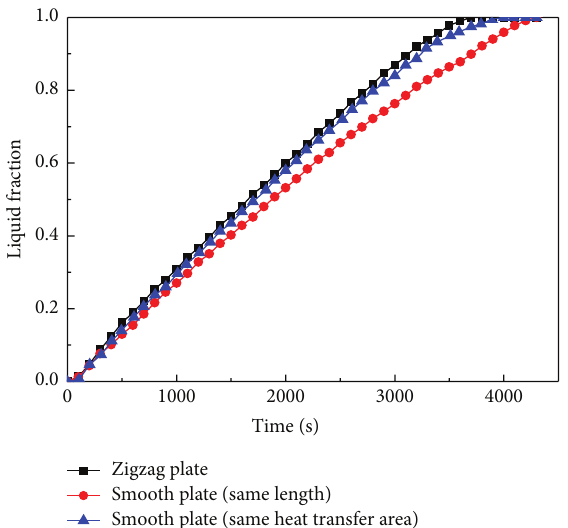
Figure 7: Liquid fraction as a function of time for the LHTES systems employing smooth and zigzag plates.